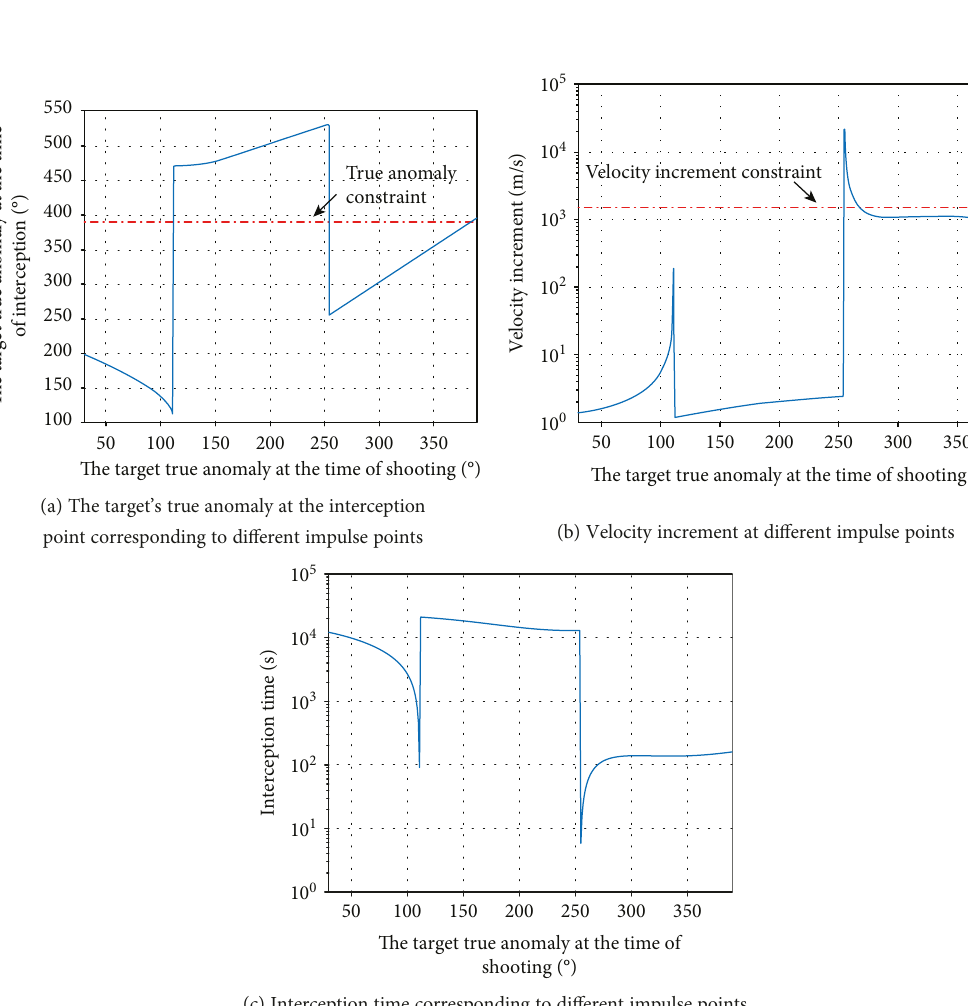
Figure 7: Iterative process for solving the minimum time tangent interception solution.